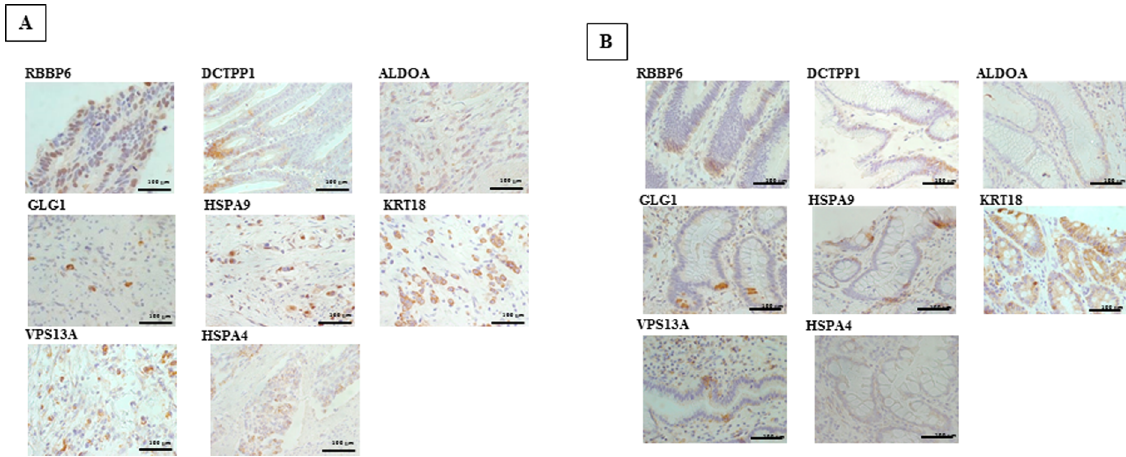
Figure 3. Immunohistochemical Determination. (a) Expression in cancer cells. RBBP6, DCTPP1, and HSPA9 expression were observed primarily in the cytoplasm and nucleus. GLG1, VPS13A, HSPA4, ALDOA, and KRT18 were expressed in the cytoplasm. (b), Expression in epithelial cells. RBBP6, GLG1, VPS13A, DCTPP1, and HSPA9 expression were found some cells in the epithelial gland. KRT18 were expressed in most epithelial cells. HSPA4 and ALDOA expression was not found in normal cells. doi:10.1371/journal.pone.0110736.g003 PLOS ONE |